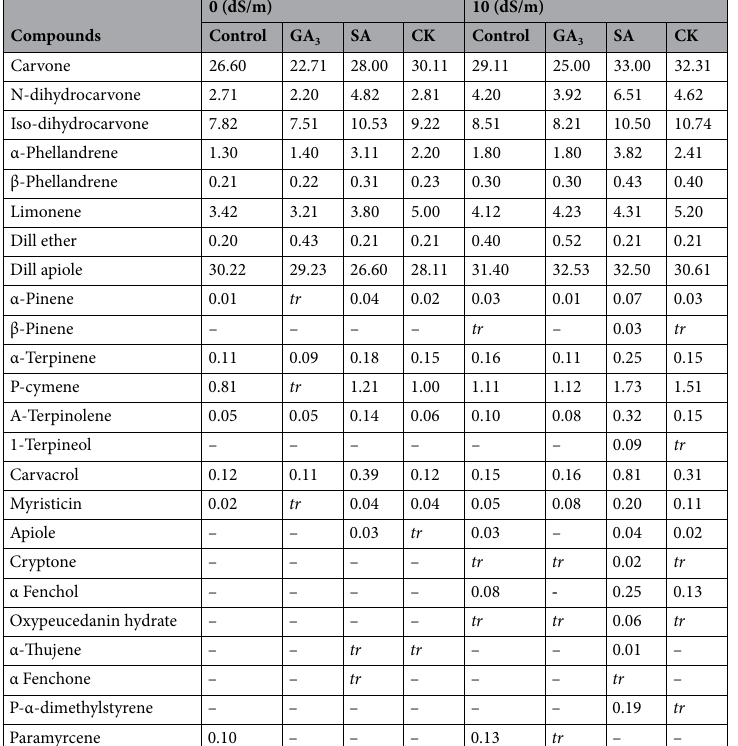
Table 1. The chemical composition (%) of essential oil of dill seeds affected by hormonal treatments under non-saline and moderate salinity at mass maturity. GA 3 gibberellic acid, SA salicylic acid, CK cytokinin.